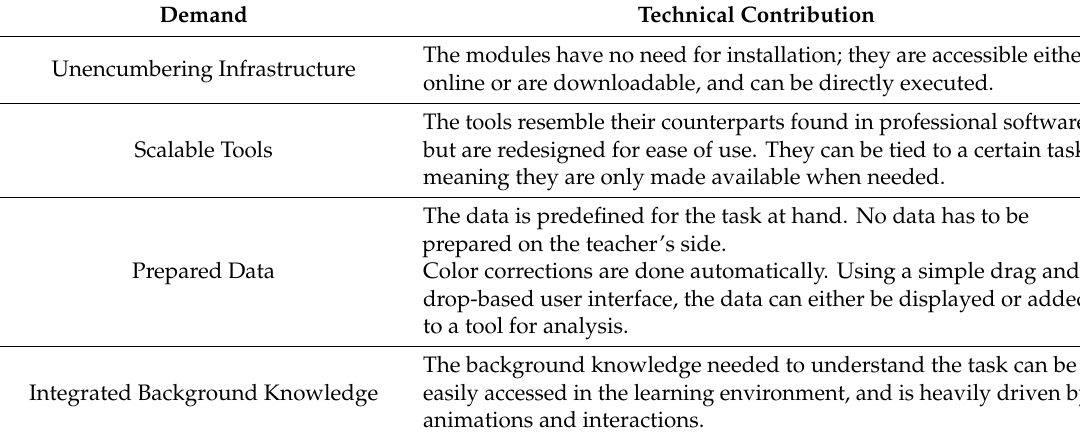
Table 1. Defined demands and how they are addressed on a technical level.